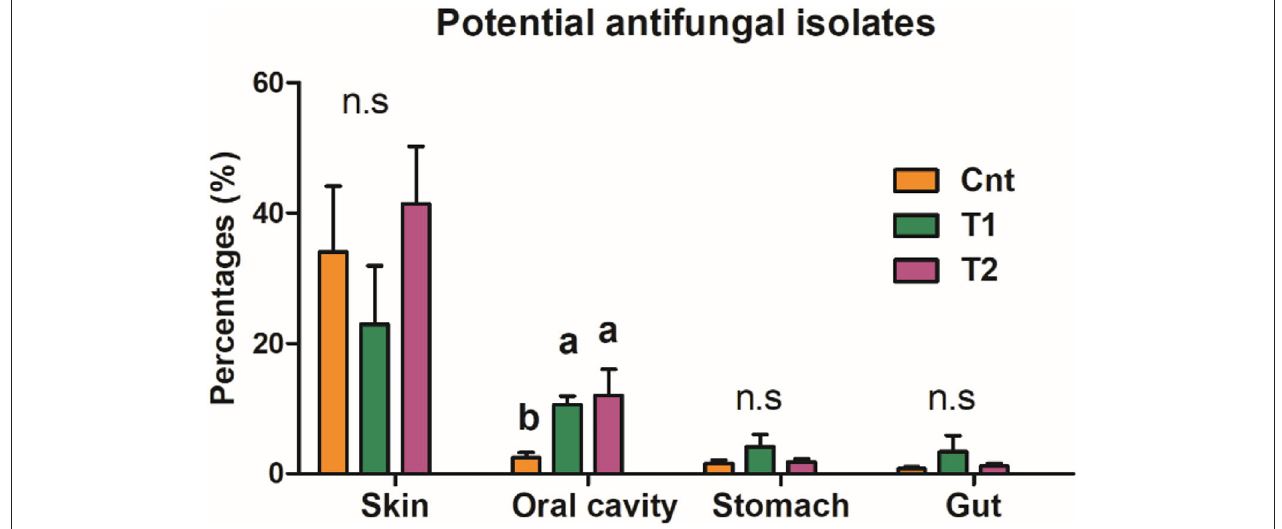
FIGURE 5 | Proportion of antifungal OTUs in commensal microbiota. The influences of pre-exposure on the abundance of antifungal isolates were tested by a one-way ANOVA and the BH correction at the level of corrected p < 0.05. Different superscripts denote significant differences between groups (LSD post-hoc tests at p < 0.05) if there is a significant